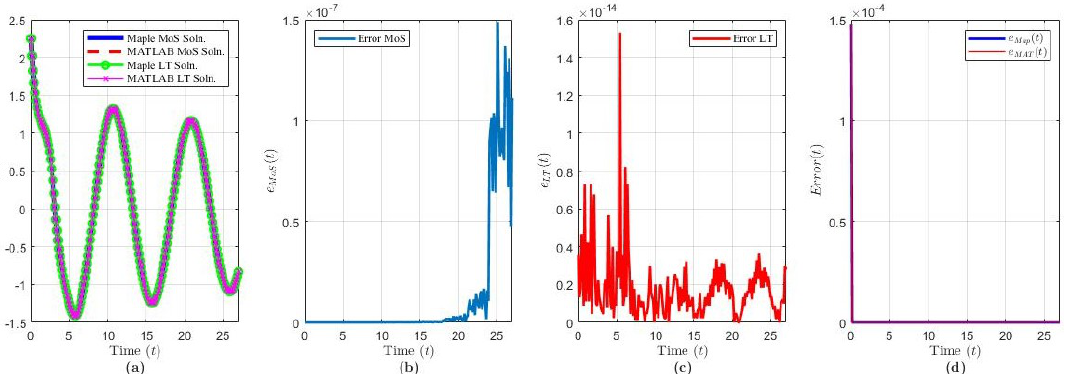
Figure 3. Solution results of Equation (20) over t ∈ [ 0,9 τ ] ( n = 5000 terms): plot of ( a ) the solution y ( t ) via each method and software, ( b ) e MoS ( t ) , ( c ) e LT ( t ) , ( d ) e Map ( t ) and e MAT ( t )